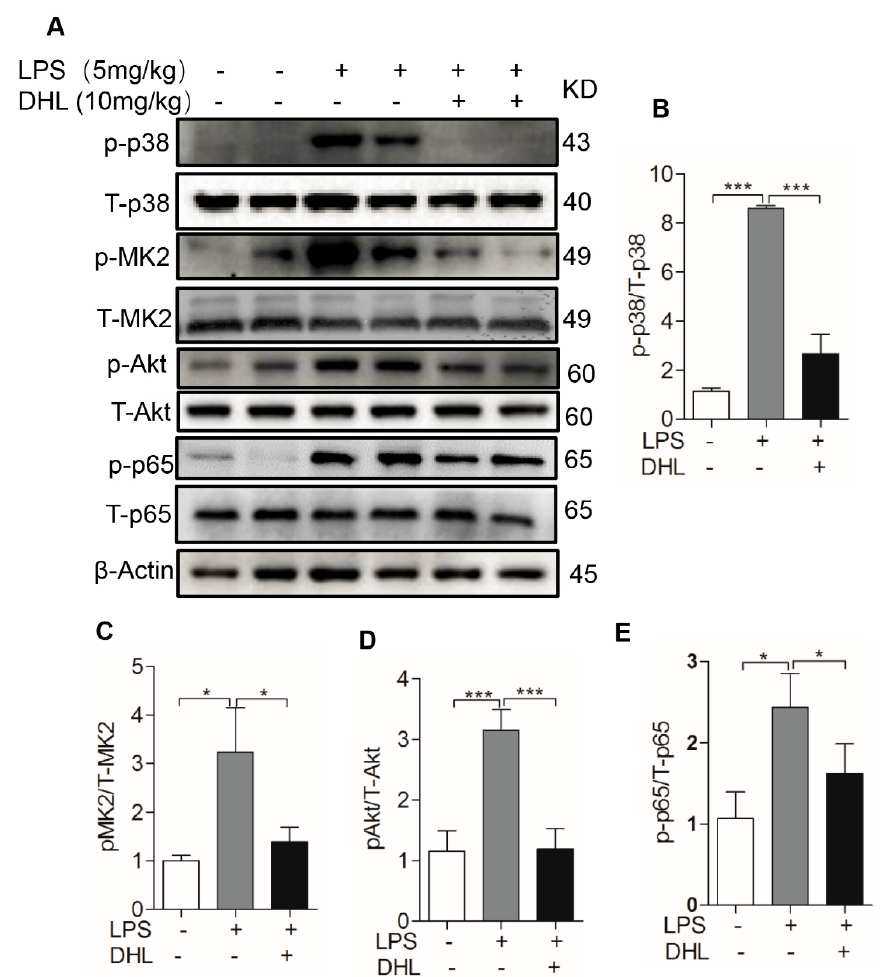
Figure 8. Phosphorylation of p38 MAPK/MK2, Akt and NF-kB involved in the anti-inflammation of DHL in vivo . Mice were subjected to an intratracheal injection of LPS (5 mg/kg) and subsequent intraperitoneal injection of solvent or DHL (5 mg/kg), then euthanized and the lung tissues were collected to measure protein expression. ( A ) The expression levels of specific proteins were evaluated by western blotting. ( B – E ) The quantitative analysis of the ratios of p -p38/T-p38, p-MK2/MK2, p-Akt/Akt, and p-p65/p65 normalized with β -actin, was performed using ImageJ software. Data represents means ± SEM, n = 6–8, * p < 0.05, ** p < 0.01 and *** p < 0.001.